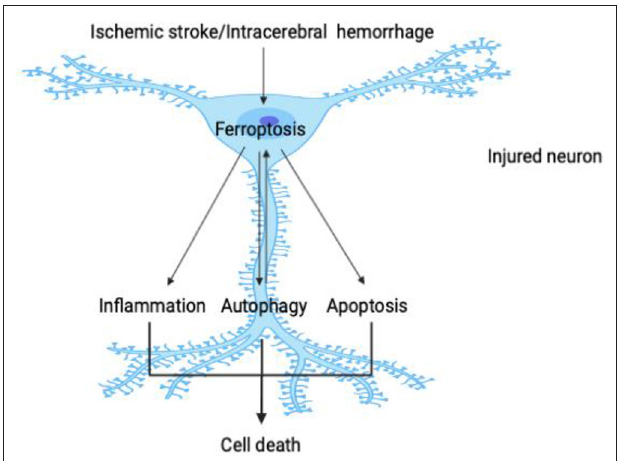
FIGURE 2 | Crosstalk between ferroptosis and other pathological processes in stroke. As shown in the figure, the pathological stimulation caused by stroke causes ferroptosis in damaged neurons; and as one of the core events in cell injury, ferroptosis can then further promote neuroinflammation, autophagy, and apoptosis. Ferroptosis is triggered interactively with these pathological processes and participates in a close one-way or even two-way relationship so that, in the process of stroke, these key constituents initiate a variety of cascade reactions and jointly determine the survival of